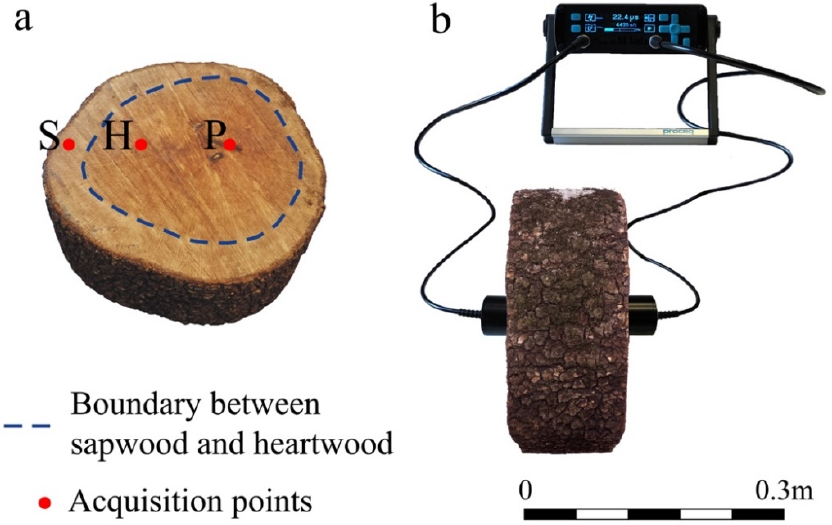
Figure 5. ( a ) Acquisition points for ultrasonic measurements in pith (P), heartwood (H) and sap- wood (S); ( b ) ultrasonic measurements in the longitudinal direction according to the direct acqui- sition